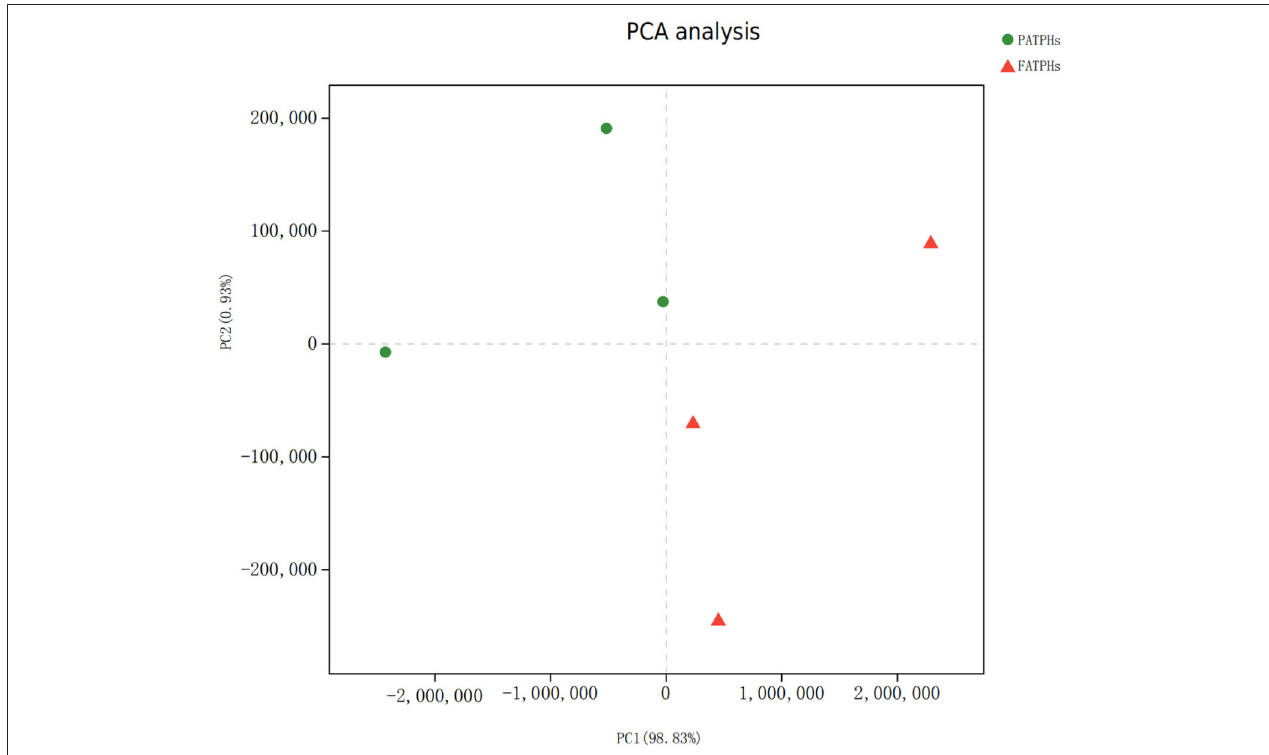
FIGURE 10 | PCA analysis of FATPHs and PATPHs based on calculation of the numbers of reads annotated to COG functions. Both chart axes have accounted for 99.76% of variance. Red triangles represent samples of FATPHs, while green dots represent samples of PATPHs.